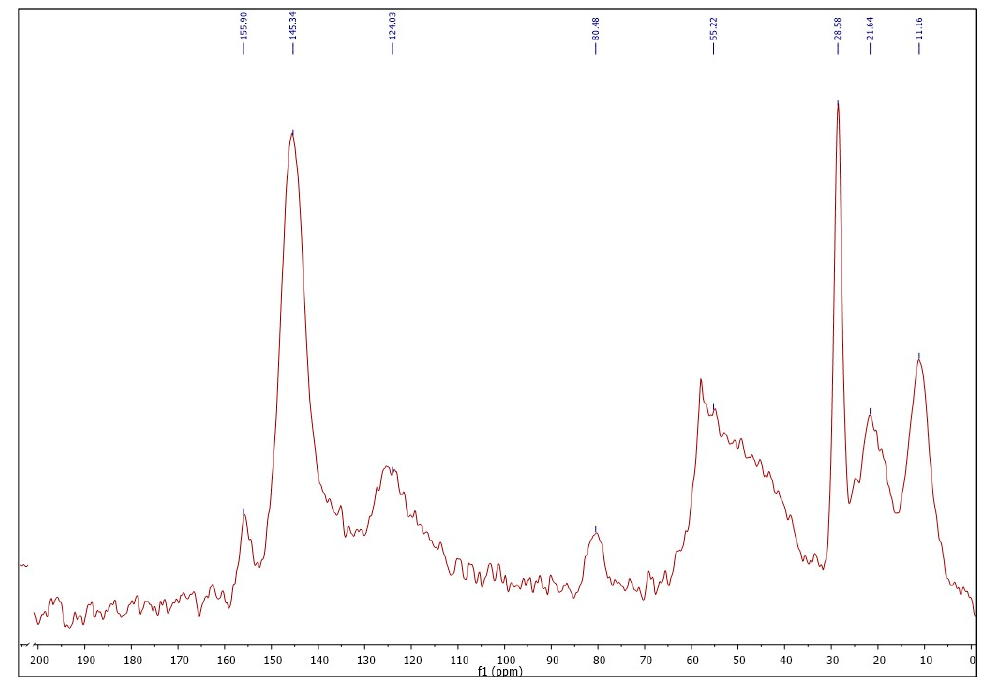
Figure 5. 13 C ‐ CP ‐ MAS solid ‐ state NMR of E ‐ P2 75/25 .